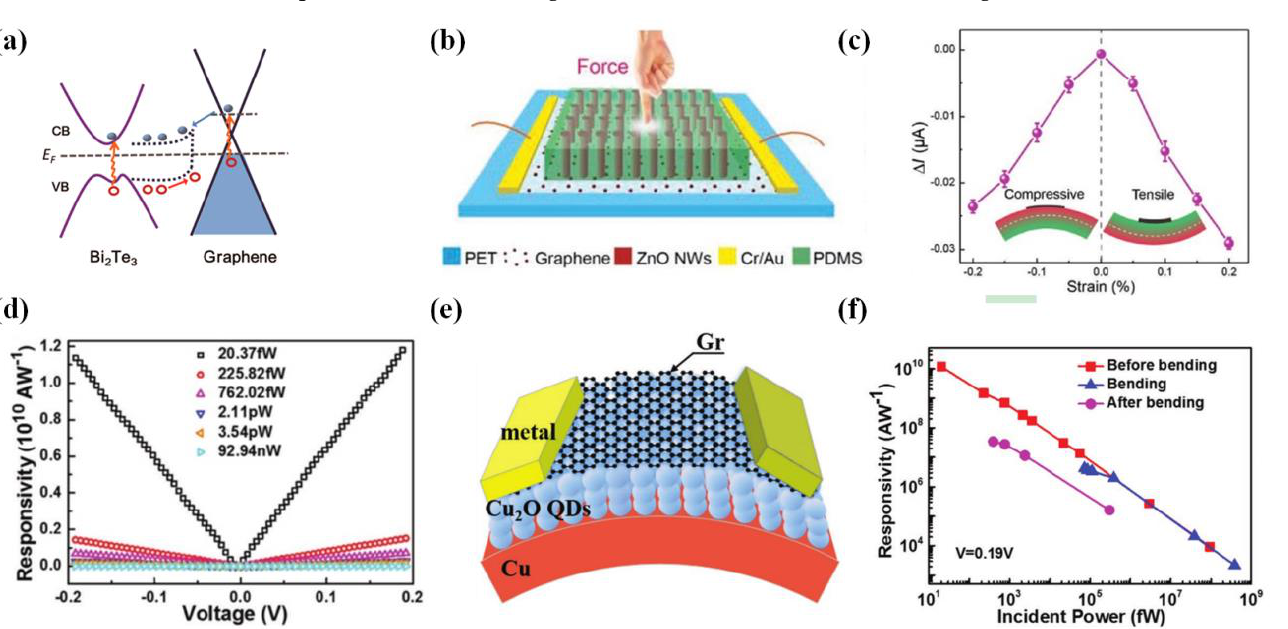
Figure 3c. The light response rate of this device at a wavelength of 325 nm is 3.5 µ A/W; additionally, it has high photosensitivity and a response speed of 28/25 ms. Compared with traditional optoelectronic devices, flexible devices usually have poor performance due to interfacial problems. The interfaces of optoelectronic devices can be optimized by improving the contact between their layers. The discontinuity between the functional layer and substrate also reduces the performance of the device. Liu et al. [99] introduced per- ovskite nanosheets between ZnO and graphene layers and found that the photomultiplier tube showed an illumination ratio of ~10 3 , an order of magnitude superior to that of a photomultiplier without CsPbBr 3 . The performance of this flexible PD is stable, with its photocurrent exceeding 93% of the maximum value after being bent 500 times [100].